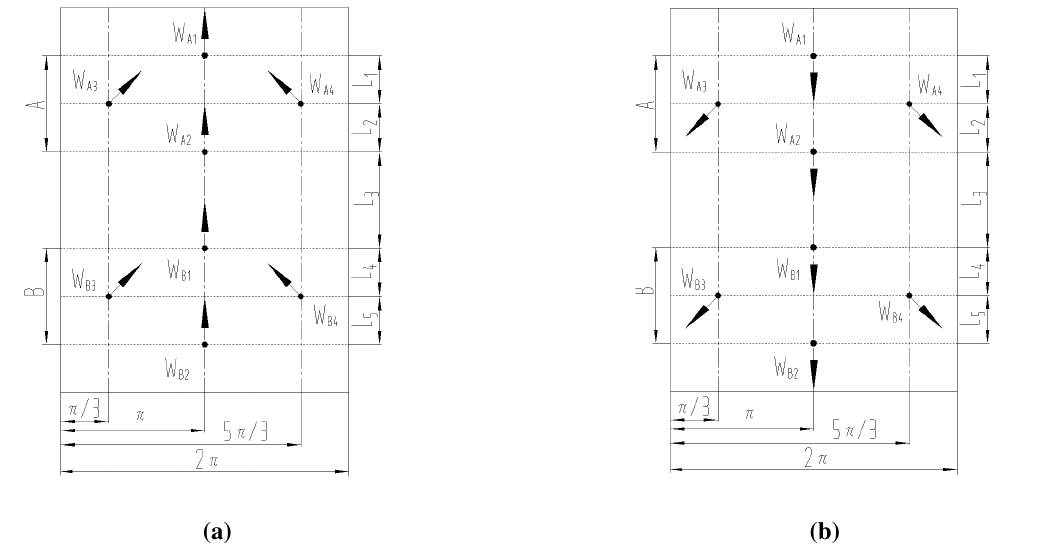
Fig. 5 Driving wheels walk along the double inverted